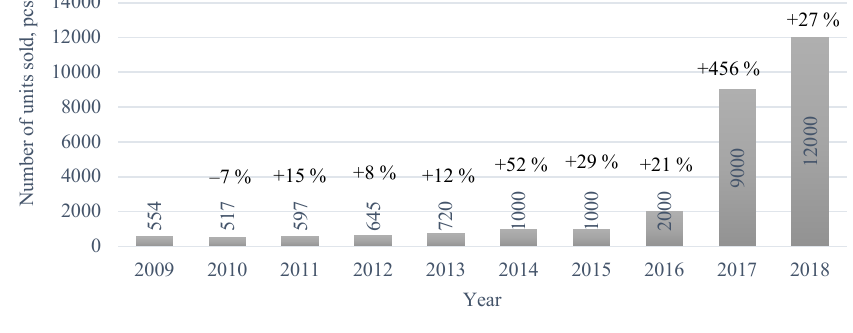
Fig. 11. The development of heat pump sales in